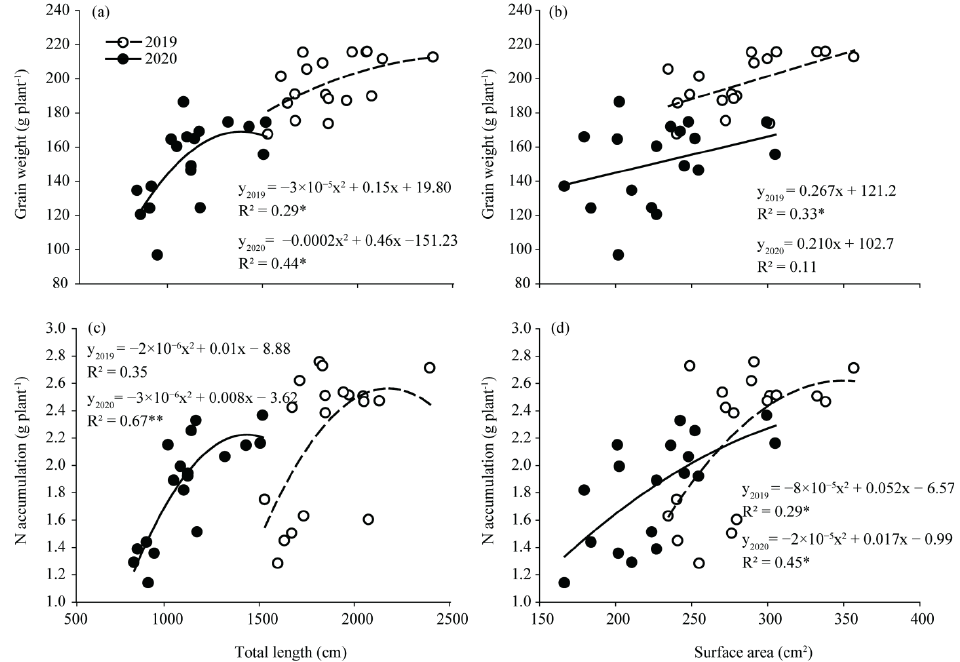
Figure 7. Relationship among total root length, surface area, grain yield, and N accumulation in six maize cultivars under three different N treatments. ( a ) Relationship between total root length and grain yield, ( b ) Relationship between root surface area and grain yield, ( c ) Relationship between total root length and N accumulation, ( d ) Relationship between root surface area and N accumulation. * significant at p < 0.05, ** significant at p < 0.01.